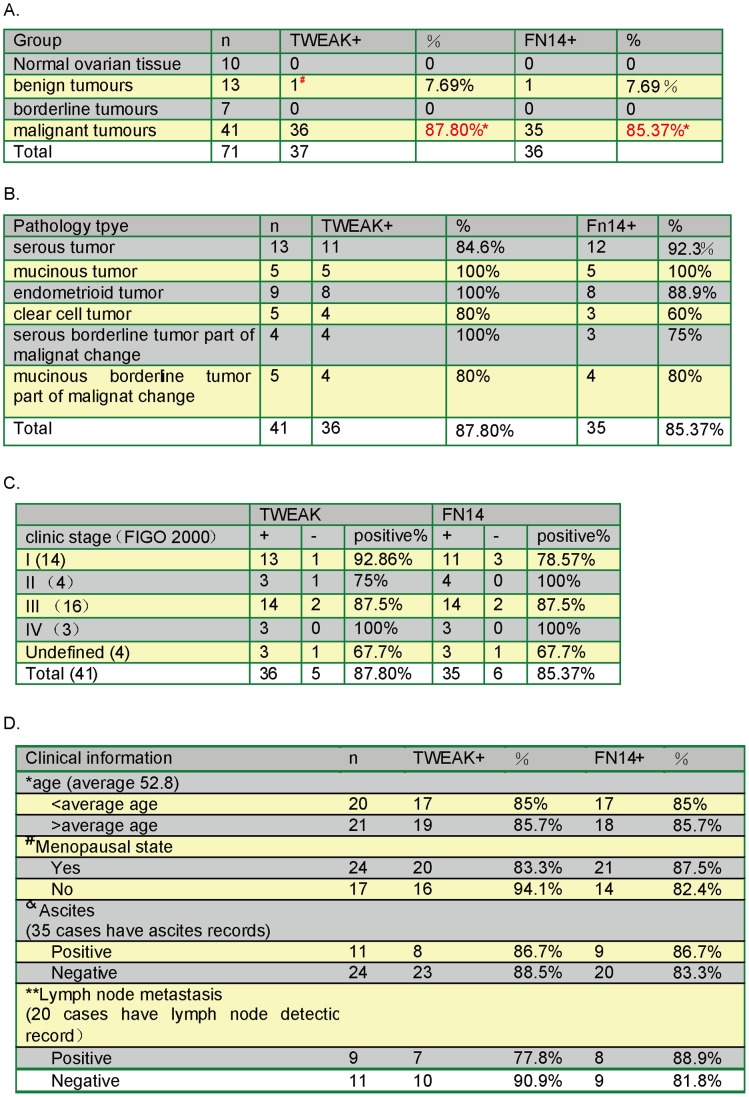
In malignant ovarian tumors, TWEAK/Fn14 expression was not corrected with patients’ clinical subtype/stages or pathological features.
(A) The expression profile of TWEAK and Fn14 in different ovarian tissues (*p<0.0001, χ2 test, α = 0.05). (B) The expression profile of TWEAK and Fn14 in malignant ovarian tumors with different pathological type. (C) The expression profile of TWEAK and Fn14 in malignant ovarian tissues with different clinical stage (based on FIGO 2000). (D) The expression profile of TWEAK and Fn14 in malignant ovarian tissues of patents with different clinical information.